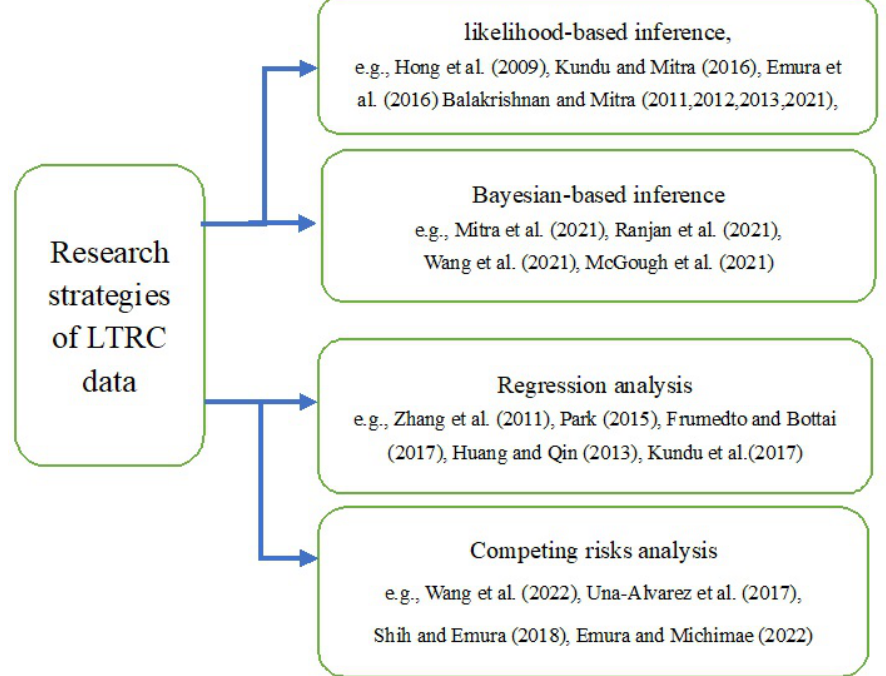
Figure 1. Research strategies of LTRC data